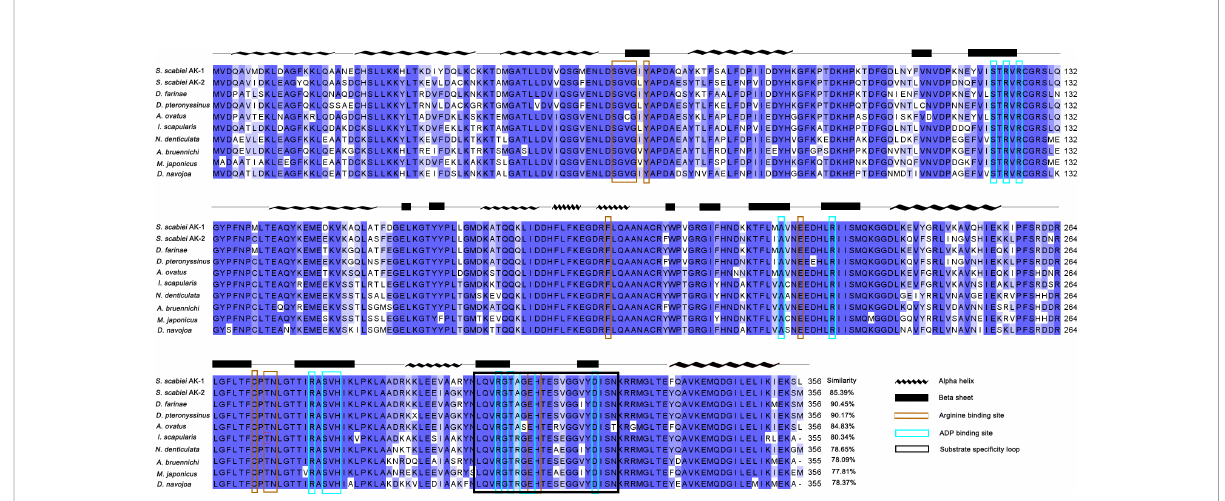
FIGURE 1 Multiple sequence alignment analysis of SsAK-1 and SsAK-2. The homology of the SsAKs to other species is shown on the right. Blue background indicates amino acids that are identical to the AKs of other species; a darker color indicates a higher consistency. Blue-green box highlights the ADP binding site. Brown box highlights the arginine binding site. The black box indicates the substrate speci fi city loop. The predicted secondary structure of the SsAKs is shown above the amino acid residue alignments. The AK gene accession numbers of each species are as follows: SsAK-1 (KPM07362.1), sAK-2 (OP185092), D. farina (AAP57094.1), D. pteronyssinus (ACD50950.1), A. ovatus (ABU97463.1), I. scapularis (XP_029845984.1), Neocaridina denticulate (BAH56609.1), Argiope bruennichi (KAF8790721.1), Macrophthalmus